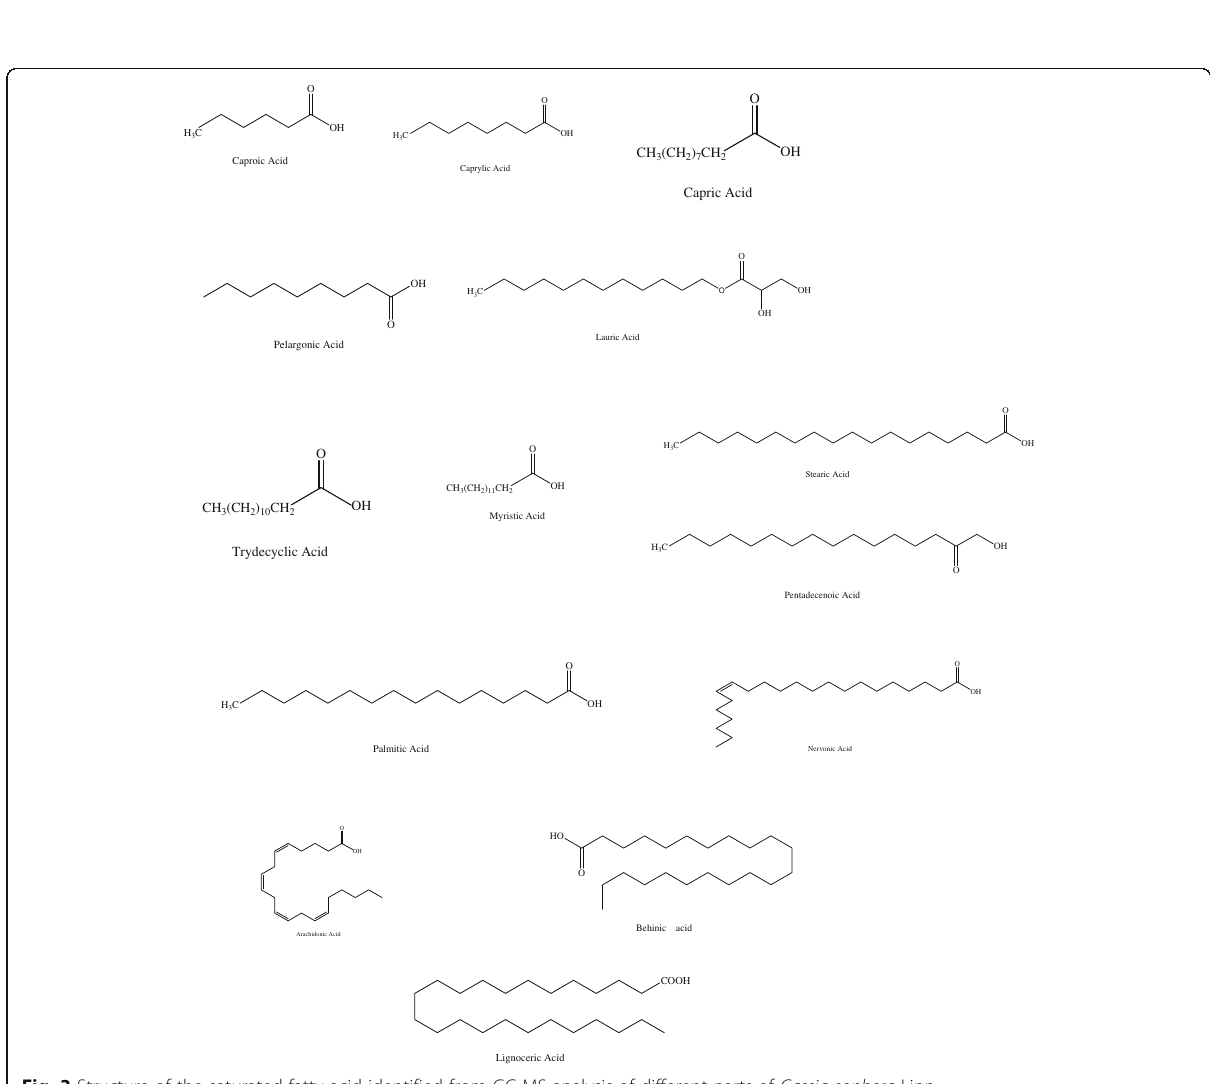
Fig. 3 Structure of the saturated fatty acid identified from GC-MS analysis of different parts of Cassia sophera